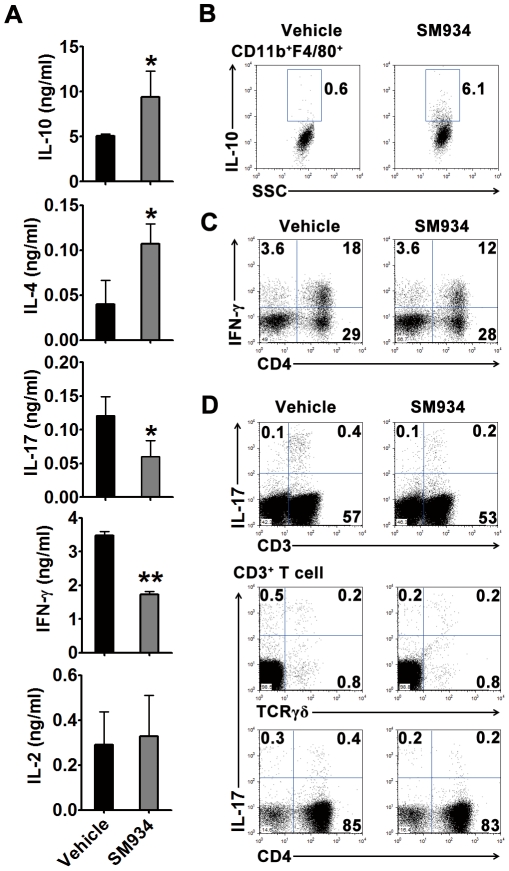
SM934 treatment suppressed Th1 and Th17 cell development and enhanced IL-10 production from macrophages.At the termination of 3 months treatment, female NZB/W F1 mice in vehicle and SM934 (10 mg/kg) treated groups were randomly and averagely divided into 3 sub-groups. Spleens of each sub-group were pooled together and ex vivo stimulated. (A) Cytokine productions in splenocytes stimulated with anti-CD3 mAb for 24 hours. Shown are mean ± SD, n = 3 in each treated group. (B) Flow cytometric analysis showing intracellular IL-10 expression in CD11b+F4/80+ macrophages. (C) Flow cytometric analysis of CD3+IFN-γ+ cells in splenocytes. (D) UP-panel, flow cytometric analysis of CD3+IL-17+ cells in splenocytes; Bottom-panel, flow cytometric analysis of intracellular IL-17 associated with surface CD4 and TCRγδ expressions. For all flow cytometry plots, shown are representative one of 3 samples with similar pattern in each treated group. * = P<0.05, ** = P<0.01 versus vehicle.